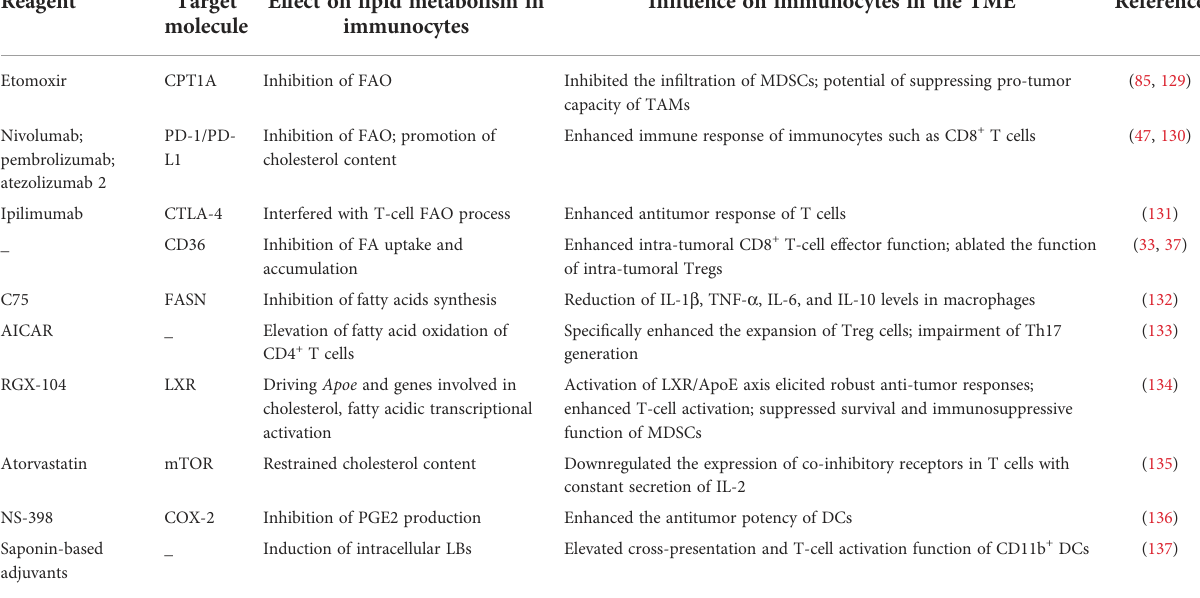
TABLE 1 Current tumor-suppressor reagents that regulate immune cell function by modulating their lipid metabolism.